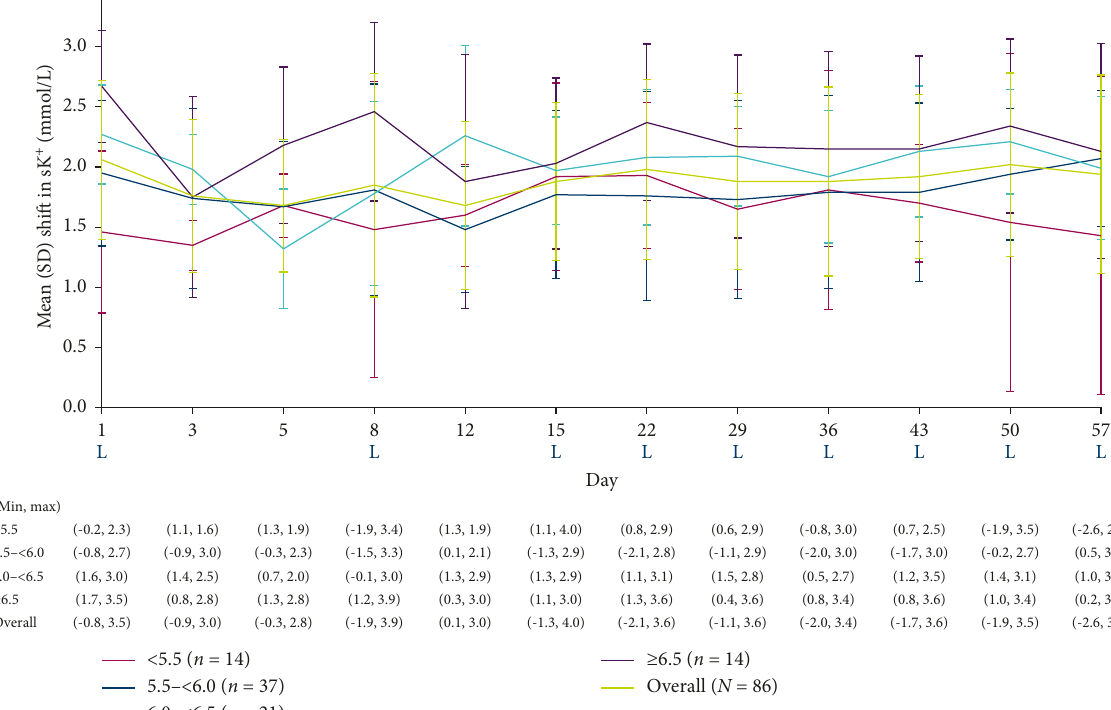
Figure 5: Shift in sK + concentration from predialysis to postdialysis at each study visit in placebo patients overall and by sK + concentration at randomization. Predialysis sK + measurement at randomization (visit 4, day 1) was used for subgroup stratification. sK + shift sK + postdialysis sK + for each visit. No imputation of missing data was conducted. L represents the LIDI visits. LIDI, long interdialytic − interval; SD, standard deviation; sK + , serum